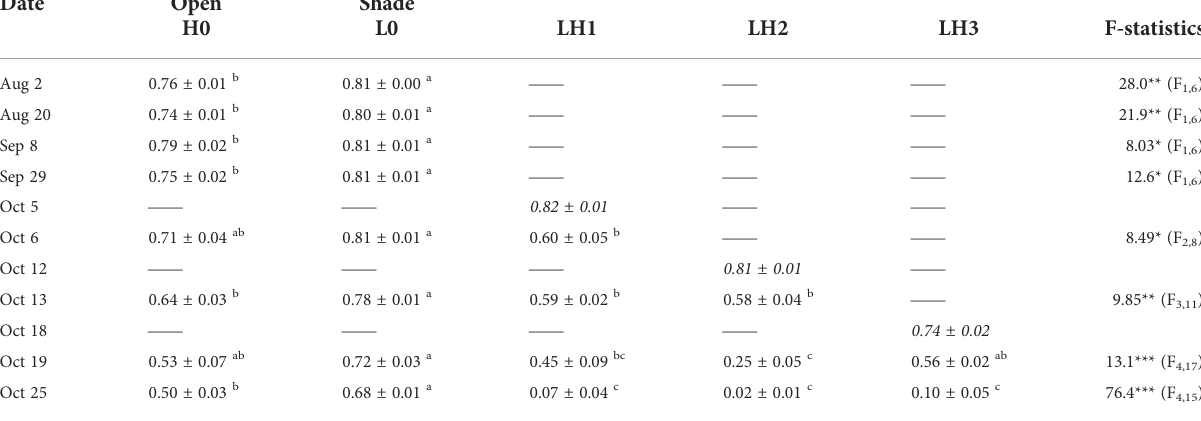
H0:opencondition,L0:shadecondition(relativeirradianceof ≈ 13%ofopencondition)throughouttheexperimentalperiod,LH1:transferfromshadetoopenonOct5,LH2:transferfrom shadetoopenonOct12,andLH3:transferfromshadetoopenonOct18.Valuesaremeans±se;n=3to6forattachedleaves.ItalicindicatesF v /F m inshade-grownleaves,measuredinthe morningof the day oftransfer. * denotes signi fi cant effect atP ≤ 0.05, **P ≤ 0.01,and ***P ≤ 0.001.ns indicates no signi fi cant effect. Different lettersindicate signi fi cant differences among means of the light treatments on the same date at P <